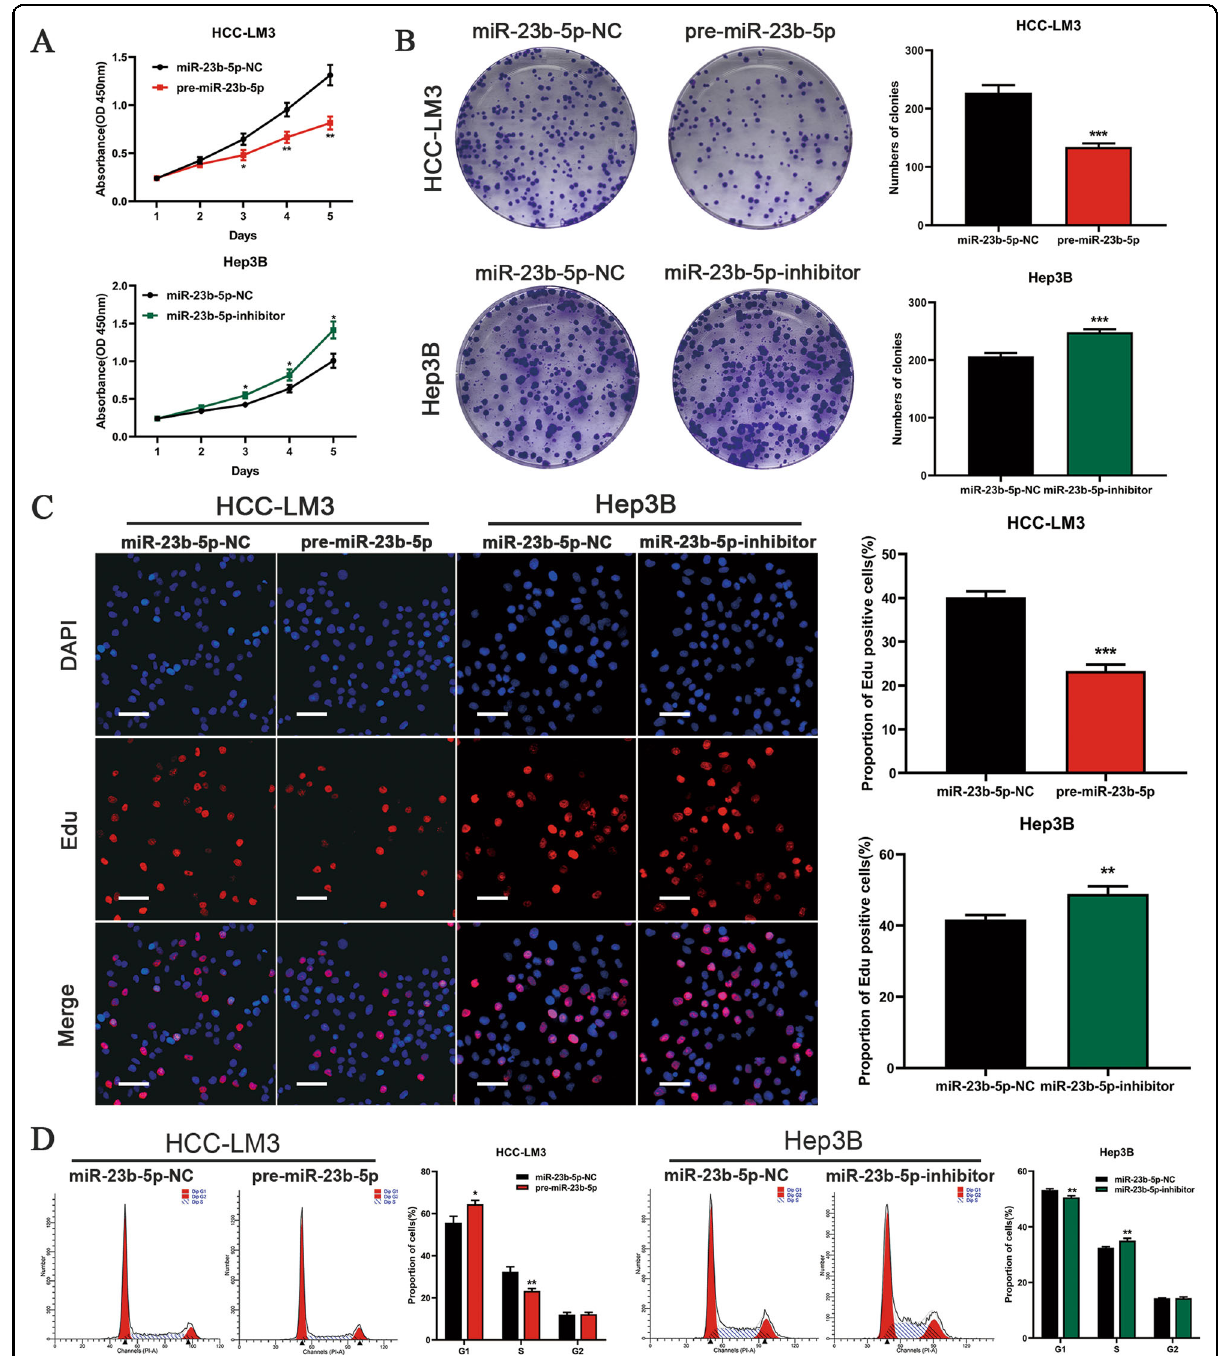
Fig. 2 miR-23b-5p suppresses HCC cell proliferation and induces cell cycle arrest. A CCK-8 assays in the HCC-LM3 and Hep3B cells overexpressing or silencing miR-23b-5p. B Colony formation assays in overexpressing or silencing miR-23b-5p HCC-LM3 and Hep3B cells. C 5-ethynyl- 2 ’ -deoxyuridine (EdU) incorporation assays were performed to explore the cell proliferation in miR-23b-5p-overexpressing or -silencing HCC-LM3 and Hep3B cells (scale bars, 50 μ m). D The fl ow cytometry results showed the contribution of miR-23b-5p overexpressing or silencing in HCC-LM3 and Hep3B cells to cell cycle. All data are presented as the mean ± S.E.M. (* P < 0.05, ** P < 0.01, and *** P <